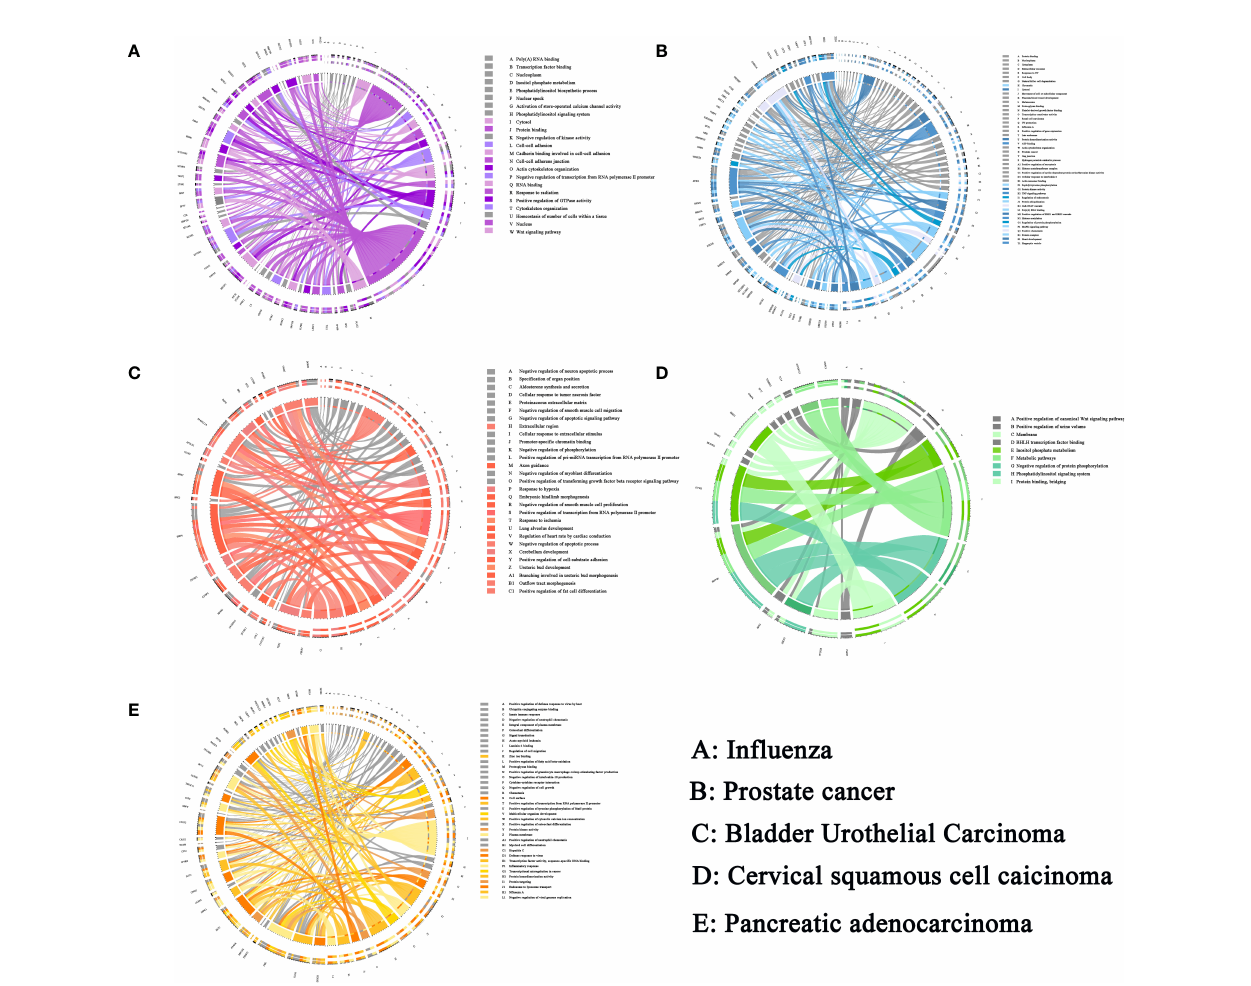
FIGURE 5 | The sJSD signal biomarkers are involved in important biological processes in fi ve datasets. (A) The GO and KEGG enrichment pathway of in fl uenza. (B) The GO and KEGG enrichment pathway of prostate cancer. (C) The GO and KEGG enrichment pathway of BLCA. (D) The GO and KEGG enrichment pathway of CESC. (E) The GO and KEGG enrichment pathway of PAAD. The left side of the outer ring represents sJSD signal biomarkers detected by our algorithm and the right side of the outer ring represent detailed biological processes in which these genes are involved. In the inner ring, the Color and width of links respectively indicate diverse enrichment pathway and signi fi cant levels of genes